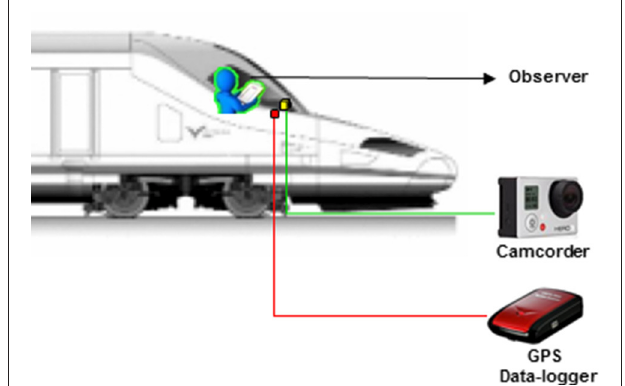
FIGURE 1 | Basic diagram of the collision detection system for a high-speed train. In the train cabin, a high-speed camera was aimed forward, connected to a data logger that records GPS navigation data continuously. In parallel, an observer records on a form the crossing and collision of birds with the train.